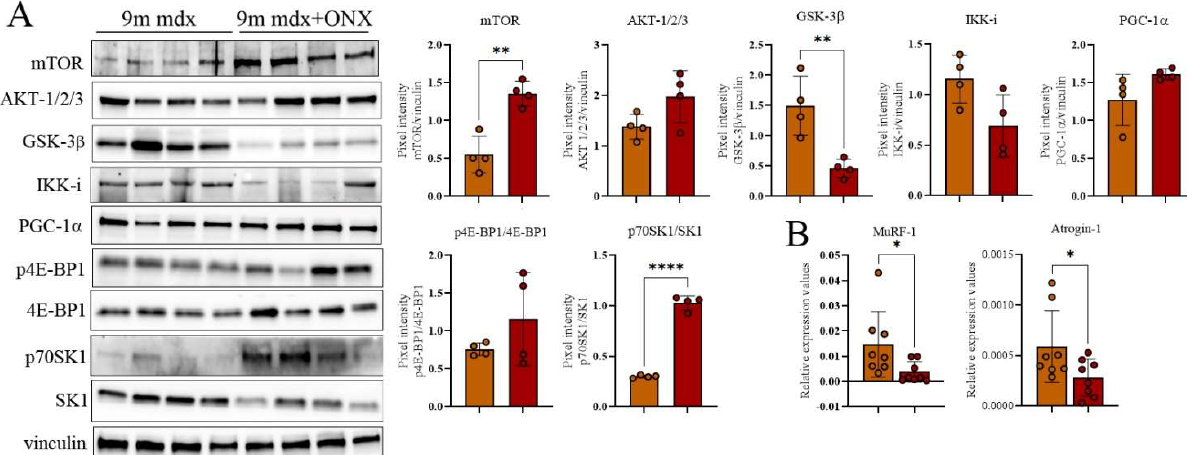
Figure 5. Evaluation of muscle wasting in 9m mdx and 9m mdx+ONX mice. Cropped images of representative WB showing ( A ) the expression of proteins involved muscle wasting as GSK-3β, IKK-i and PGC-1α; mTOR/AKT signaling and its most-common downstream targets 4E-BP1 and SK in skeletal muscles from 9m mdx mice treated with ONX-0914 versus untreated mice. Densitometric analyses of protein expression is shown as ratio on vinculin or ratio phosphorylated/total isoforms. ( B ) RT-qPCR analysis of MuRF-1 and atrogin genes TA of 9m mdx and 9m mdx+ONX. Data are expressed as means ± SD of n = 3 independent experiments with n = 4 mice for animal groups (* p < 0.05, ** p < 0.01, **** p < 0.0001, with unpaired t -test).